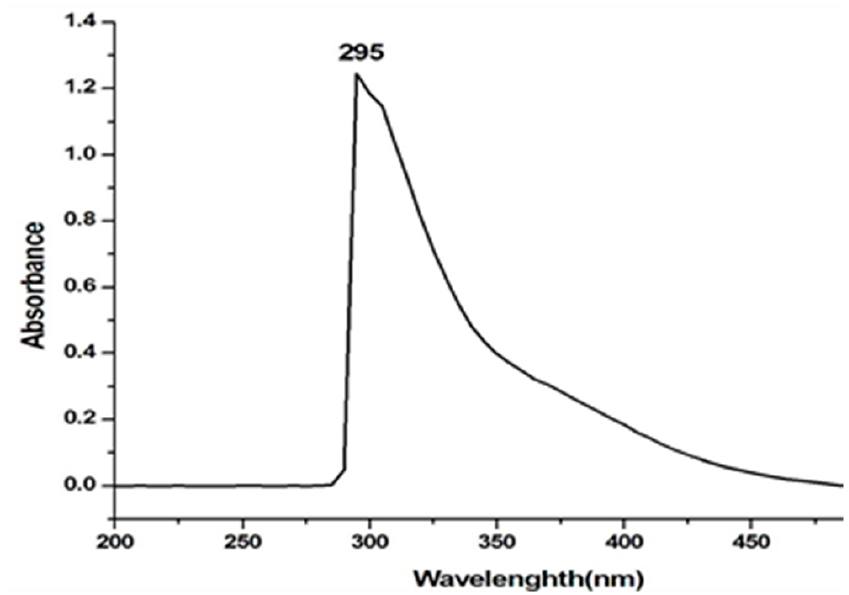
Figure 1. The ultraviolet spectrum of the phlorotannin extract from S. linifolium marine alga.